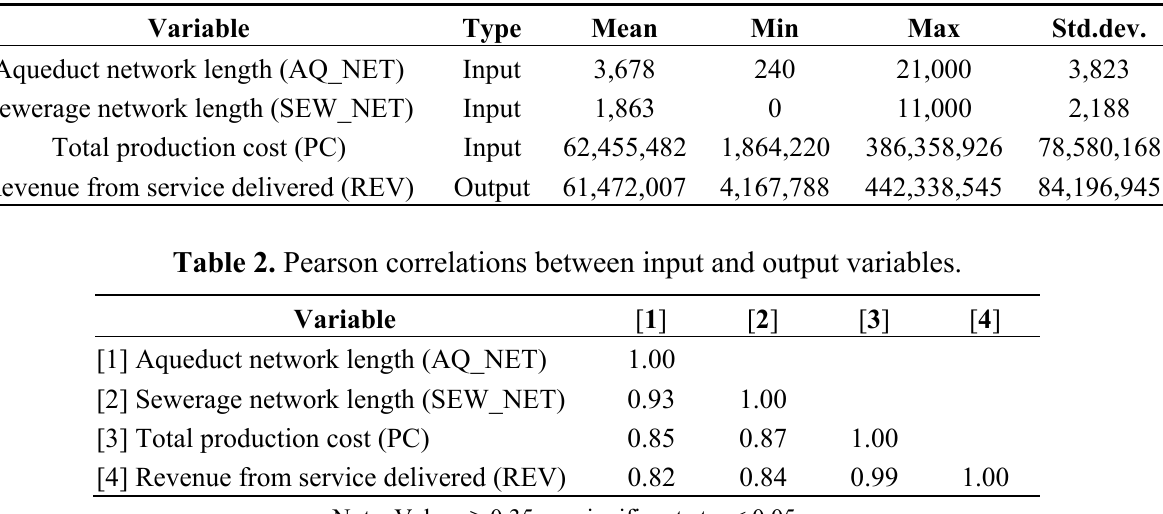
Table 1. Descriptive statistics of input and output variables.